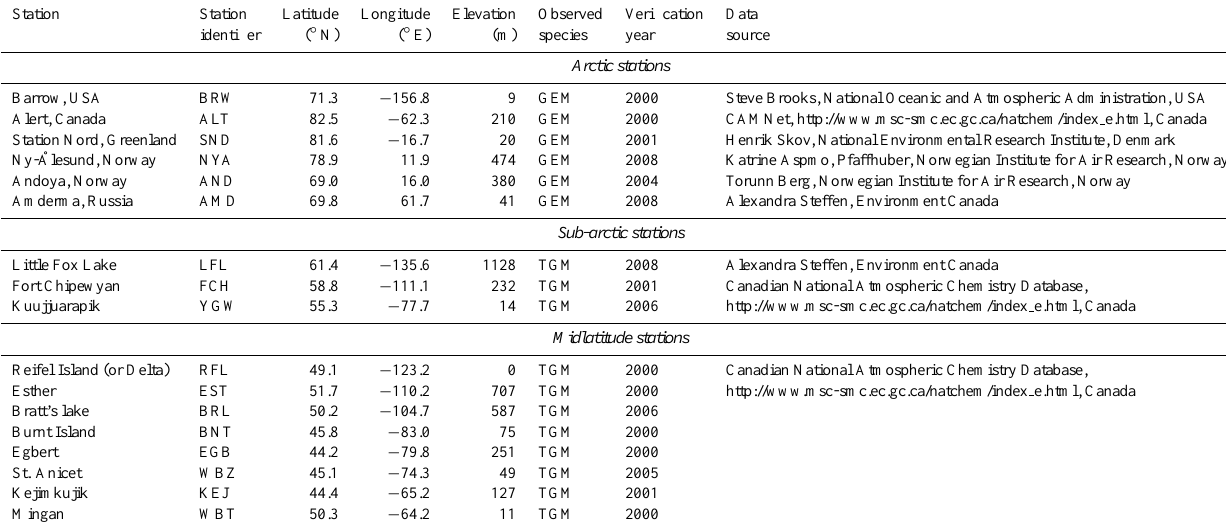
Table 1. Verification